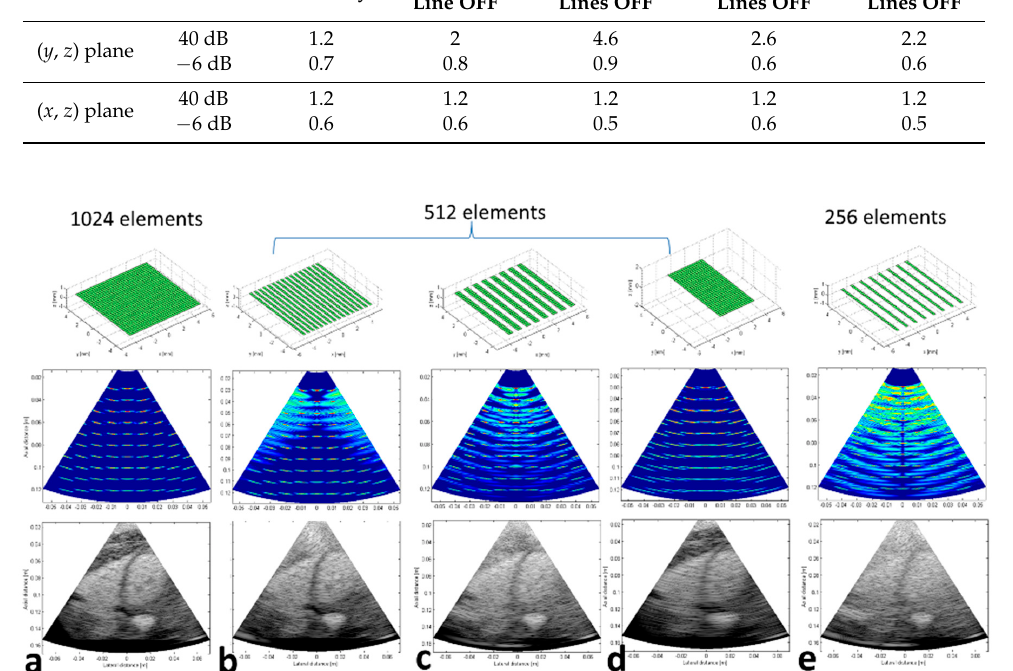
Figure 3. Numerical simulations results from Field II on equidistant scatters (2nd row) and based on an MR image of the heart (3rd row) corresponding to different configurations of the US array (1st row) in ( y , z ) plane.